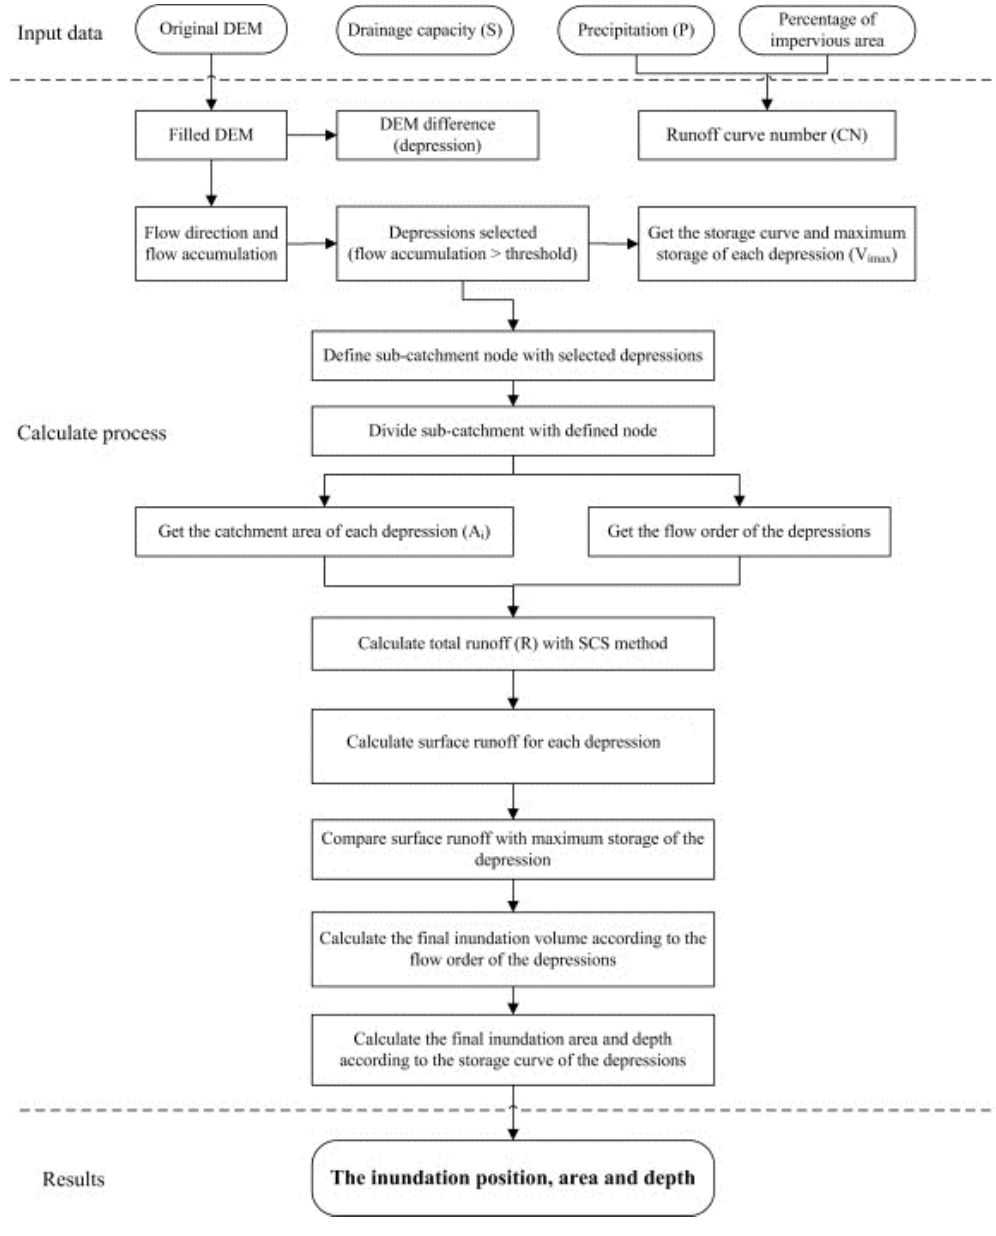
Figure 2. USISM model (Zhang & Pan,